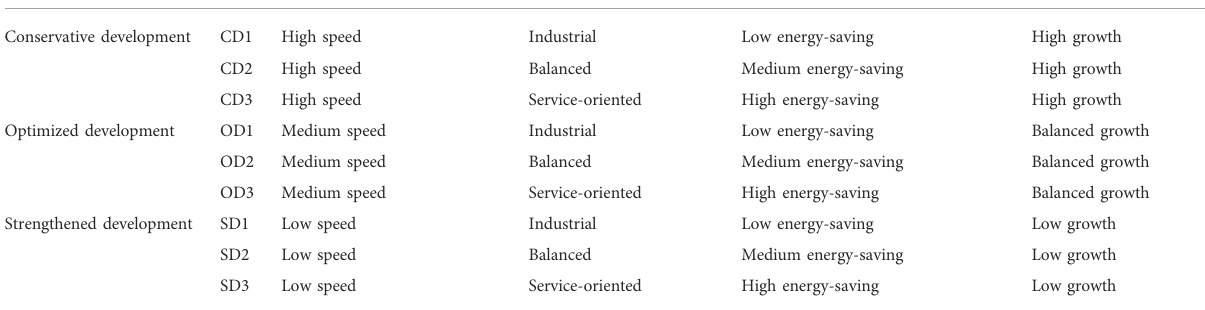
TABLE 10 Description of development scenario setting.